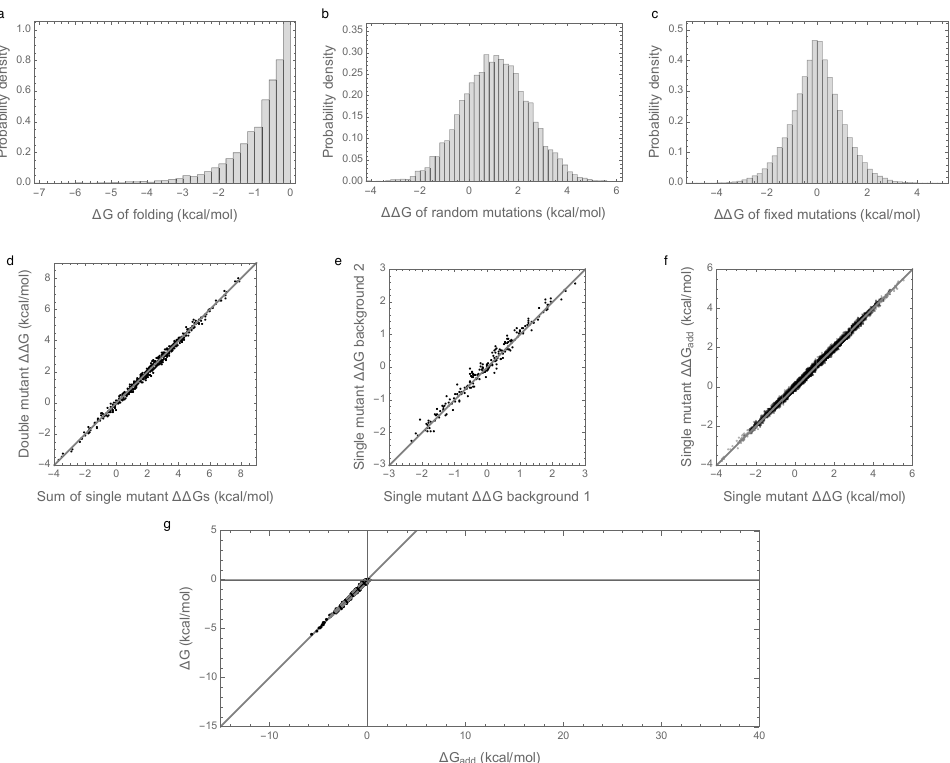
Figure 2. Free energy of folding, stability effects of mutations, and contribution of additive effects to folding stability under the independent epistatic effects model: ( a ) Distribution of free energy of folding for evolved sequences; ( b ) distribution of stability effects of random mutations, i.e., distribution of ∆∆ G values for a random single mutant generated from a random evolved sequence; ( c ) distribution of stability effects of fixed mutations, i.e., distribution of ∆∆ G values corresponding to two distinct neighboring sequences along the simulated trajectory; ( d ) stability effects of double mutations versus the sum of the stability effects of the two single mutations. 500 random double mutants are shown, R 2 = 0.993; ( e ) effects of single mutations that fixed along the trajectory in two evolved backgrounds that differ by 50% sequence divergence, R 2 = 0.98; ( f ) the stability effect of a random mutation on ∆ G is highly correlated with the stability effect of the mutation on the additive contribution ∆ G add , R 2 = 0.997; ( g ) the additive contribution to folding is a good indicator of the total free energy of folding ( R 2 = 0.99) and 95% of observed sequences can fold spontaneously based on the additive contribution alone. The dashed gray curve is derived from our bivariate normal approximation and is predicted to contain 95% of the evolved sequences. Simulations conducted under the independent epistatic effects = 1 kcal 2 /mol 2 , and σ 2 = 0.01 kcal 2 /mol 2 model with µ add = 1 kcal/mol, σ 2 HOC add